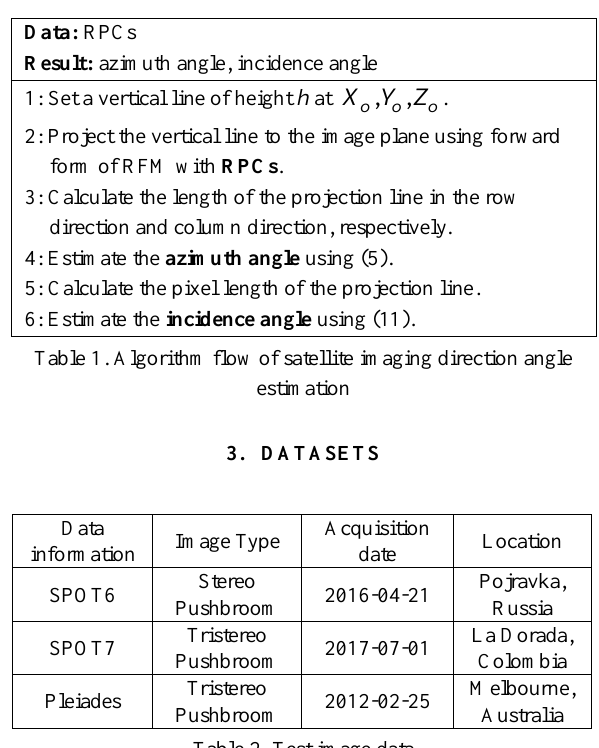
Table 2. Test image